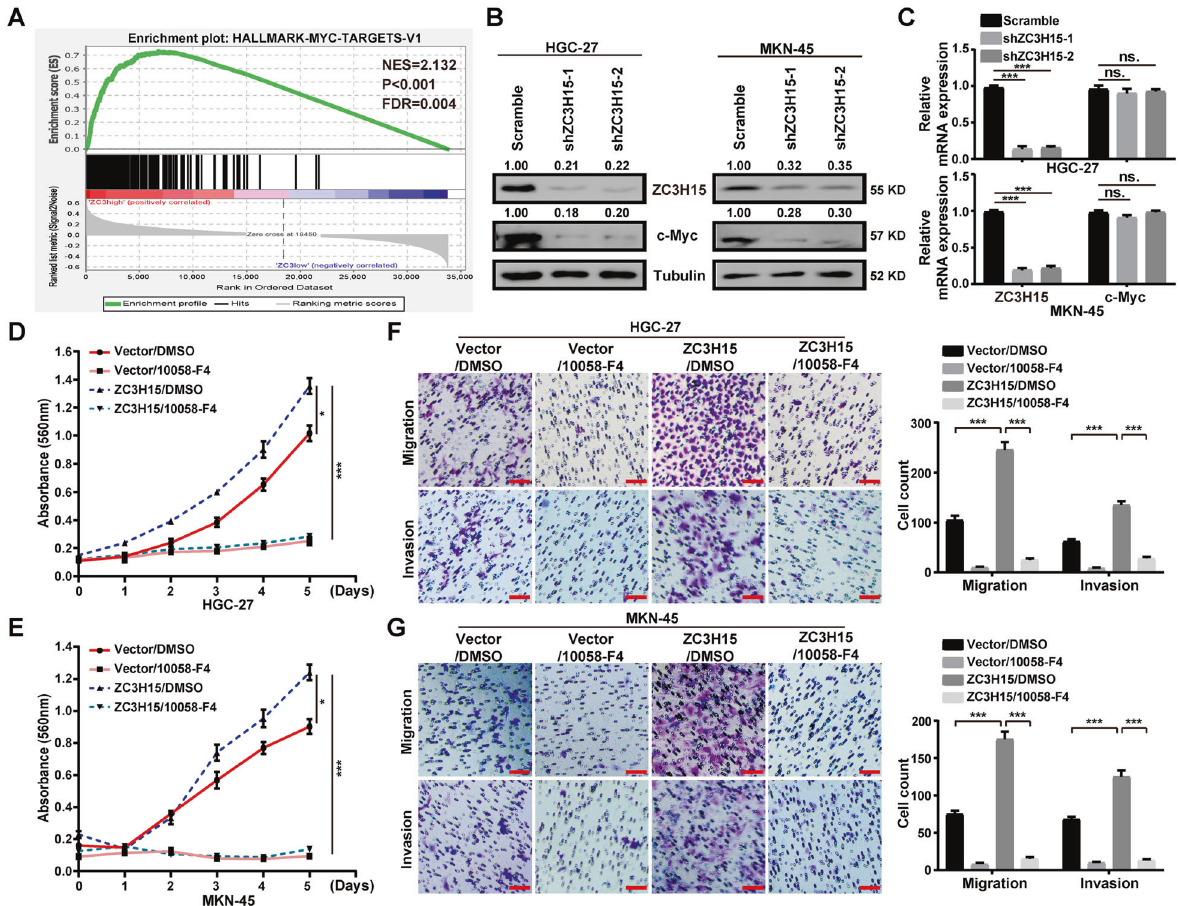
Fig. 4 ZC3H15 promoted GC progression by increasing c-Myc expression. A GSEA enrichment plots of c-Myc target genes in high ZC3H15 expression versus low ZC3H15 expression TCGA GCs. Normalized enrichment score (NES), false discovery rate (FDR), and P -values were shown in the plot. B , C ZC3H15 modulated the protein and mRNA expression of c-Myc in HGC-27 and MKN-45 cells. D , E MTT assays were performed to examine the inhibitory effect of 10058-F4 (100 μ M) on the cell proliferation of ZC3H15-overexpression HGC-27 and MKN-45 cells. F , G Transwell assays were performed to examine the inhibitory effect of 10058-F4 (100 μ M) on the cell migration and invasion of ZC3H15- overexpression HGC-27 and MKN-45 cells. All data were expressed as mean ± SD. Student ’ s t -test was performed to analyzed signi fi cance, * P < 0.05, ** P < 0.01, *** P < 0.001.